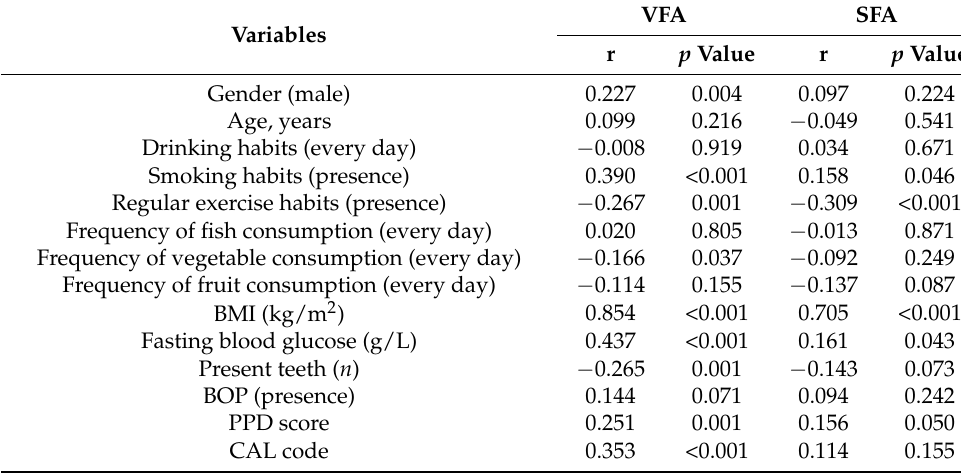
Table 3. Spearman’s rank correlation analysis of VFA and SFA.